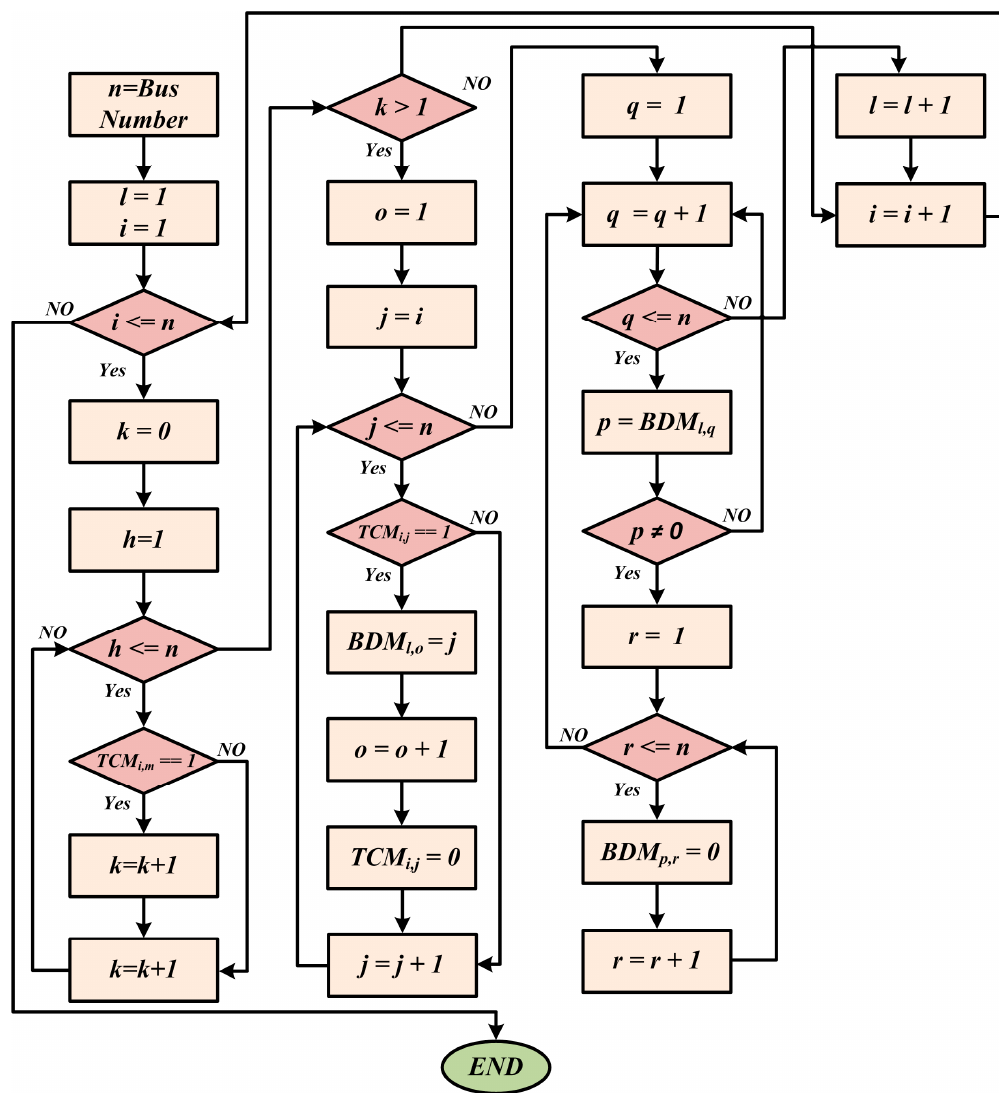
Figure 6. Procedure to extract subsections and bus-bars.